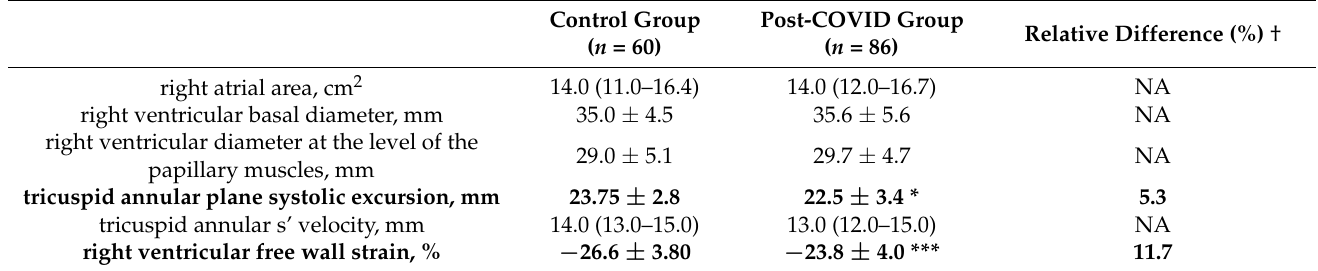
Table 4. Echocardiographic parameters of dimension and function of the right atria and right ventricle in the study